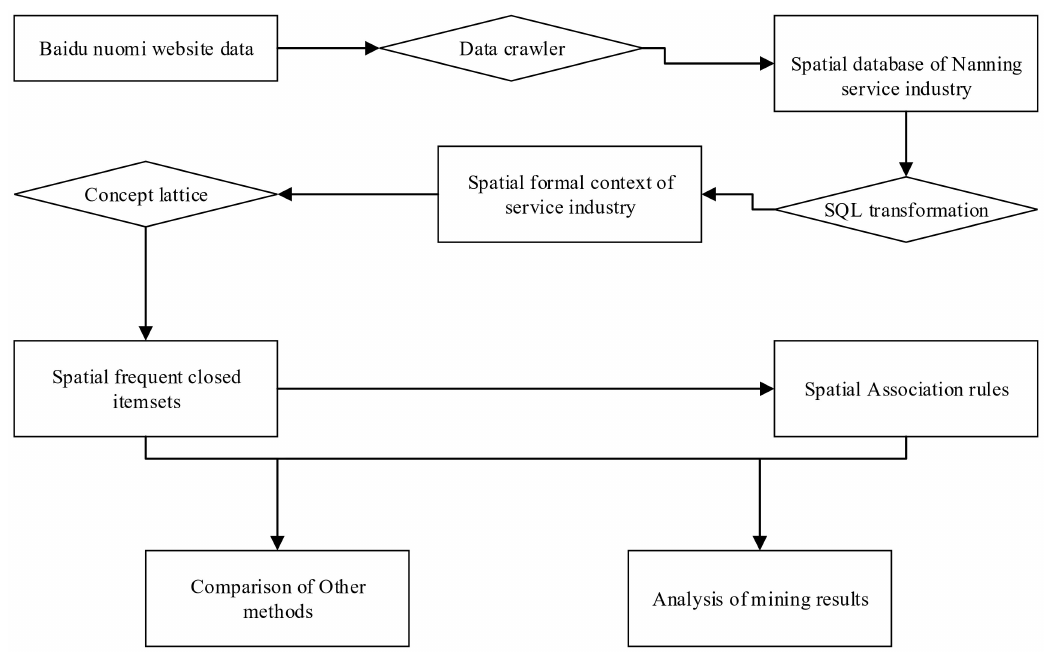
Figure 4. Computing framework for the concept lattice method of spatial association discovery in urban service industry.